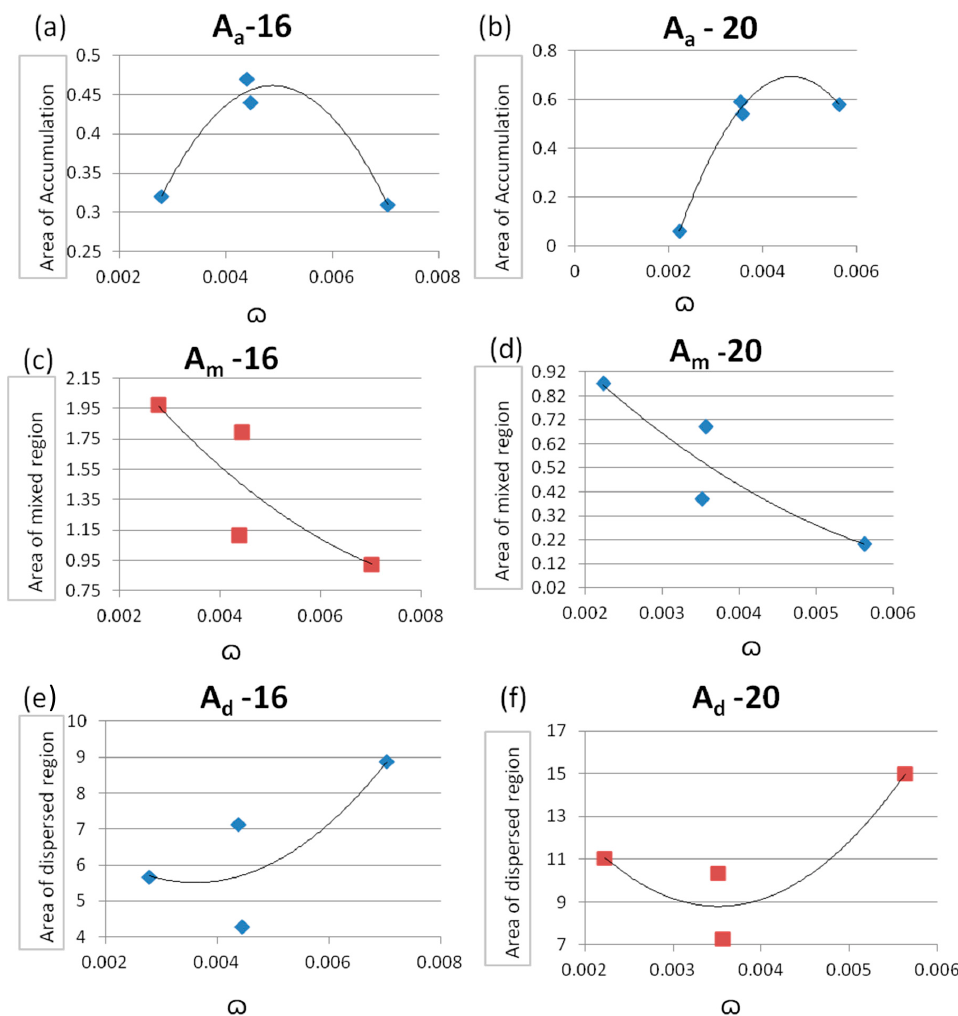
Figure 5. Effect of “ (cid:118) ” on ( a , b ) A a , ( c , d ) A m , and ( e , f ) A d for 16 and 20 mm shoulder diameter, respectively.